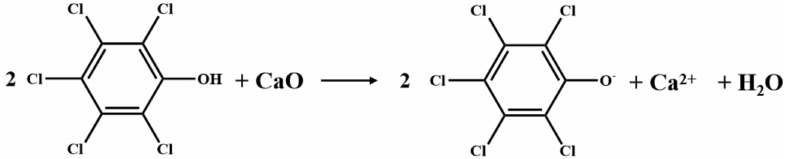
Figure 7. Schematic diagram of acid–base interaction. Reprinted with permission from Elsevier, 2022 [30].